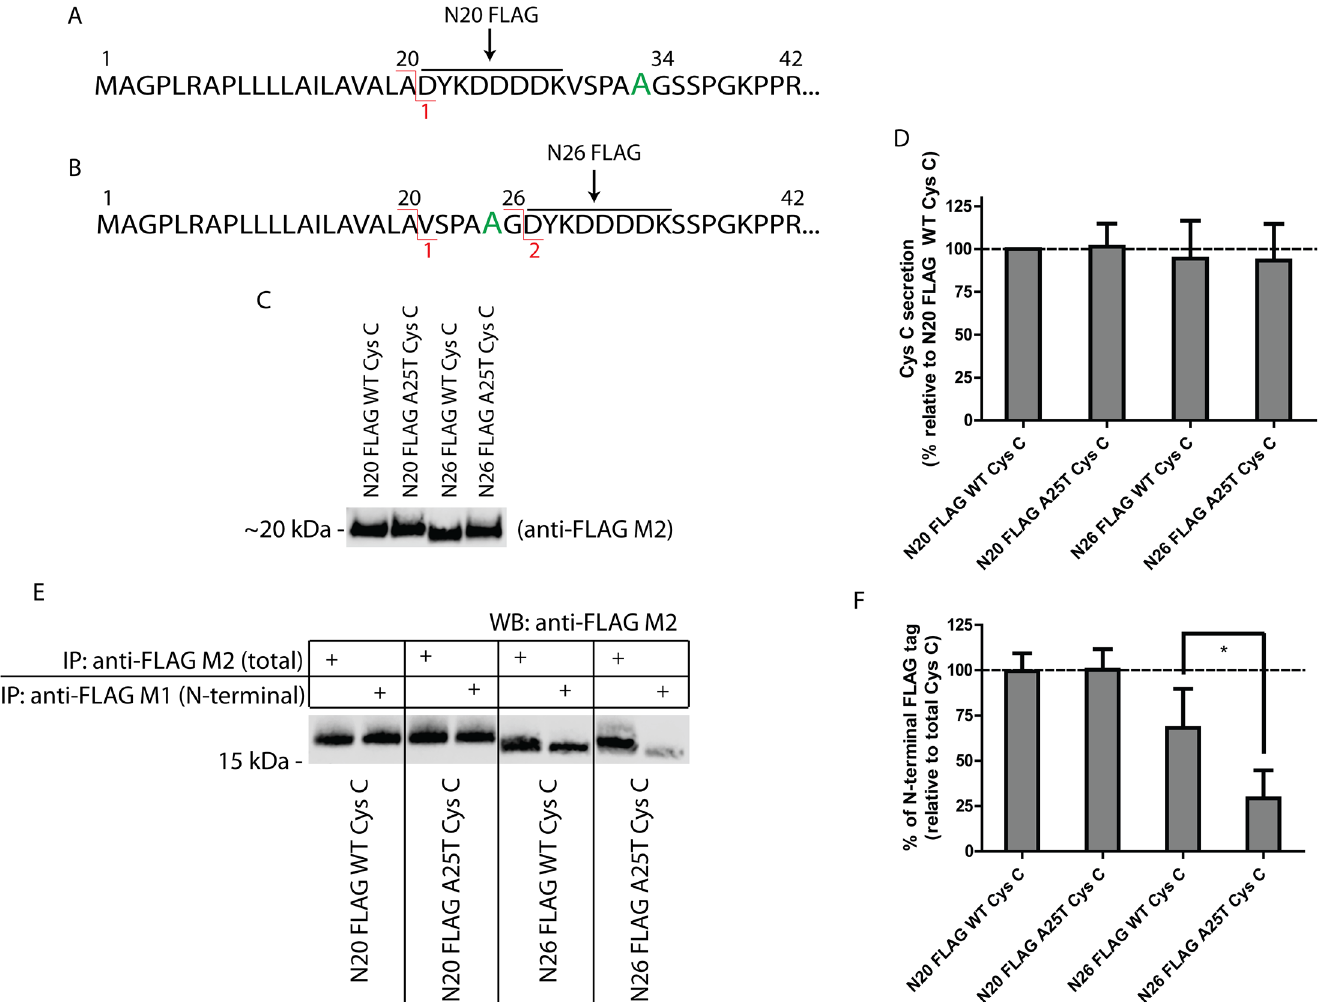
Fig 5. The A25T polymorphism predisposes Cys C to alternative signal sequence cleavage. (A) A FLAG tag after residue 20 (N20 FLAG) is predicted to eliminate site 2 cleavage. (B) However, a FLAG tag after residue 26 (N26 FLAG) is predicted to keep the two potential cleavage sites. (C) Secretion of N- terminal FLAG Cys C variants is similar. The secretion of N-terminal FLAG Cys C proteins (either N20 FLAG; FLAG tag after Ala20, or N26 FLAG; FLAG tag after Gly26) was assessed after plasmid transfection into HEK-293T cells. Representative data of at least 6 experiments. (D) Quantification of FLAG Cys C secretion in (C) by LI-COR software. n (cid:1) 6, mean ± S.D. (E) Differential IP of secreted FLAG Cys C from HEK-293T cells using either anti-FLAG M1 or anti- FLAG M2 beads. (F) Quantification of the relative levels of N-terminal (anti-FLAG M1 IP) to total (anti-FLAG M2 IP) FLAG-tagged protein. n (cid:1) 3, mean ± S.D., * = p < 0.05 by a paired